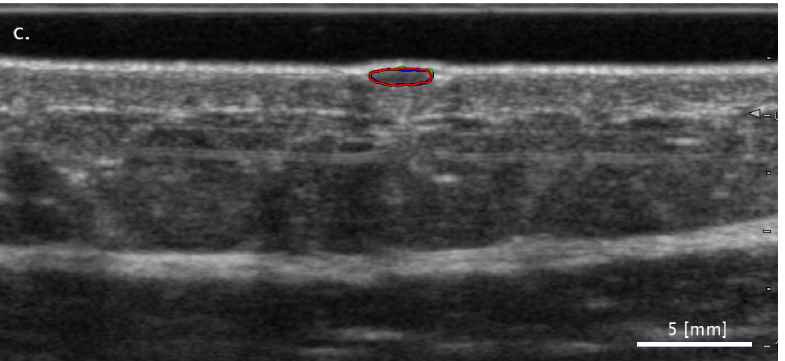
Figure 5. Examples of images with segmentation results leading to a correct ‘Nevus vs. others’ type binary classification in the case of the FA method (red mark) while failing for both SA methods (freehand: blue mark; LAR: green mark). Three notable cases are presented: ( a ) FA segmentation detected a similar but slightly shifted region from that detected by SA segmentation; ( b ) FA seg- mentation detected additional image regions as part of the lesion in comparison to the results of SA segmentations; ( c ) All three segmentation results matched closely, however slight differences in their borders led to different classification results.